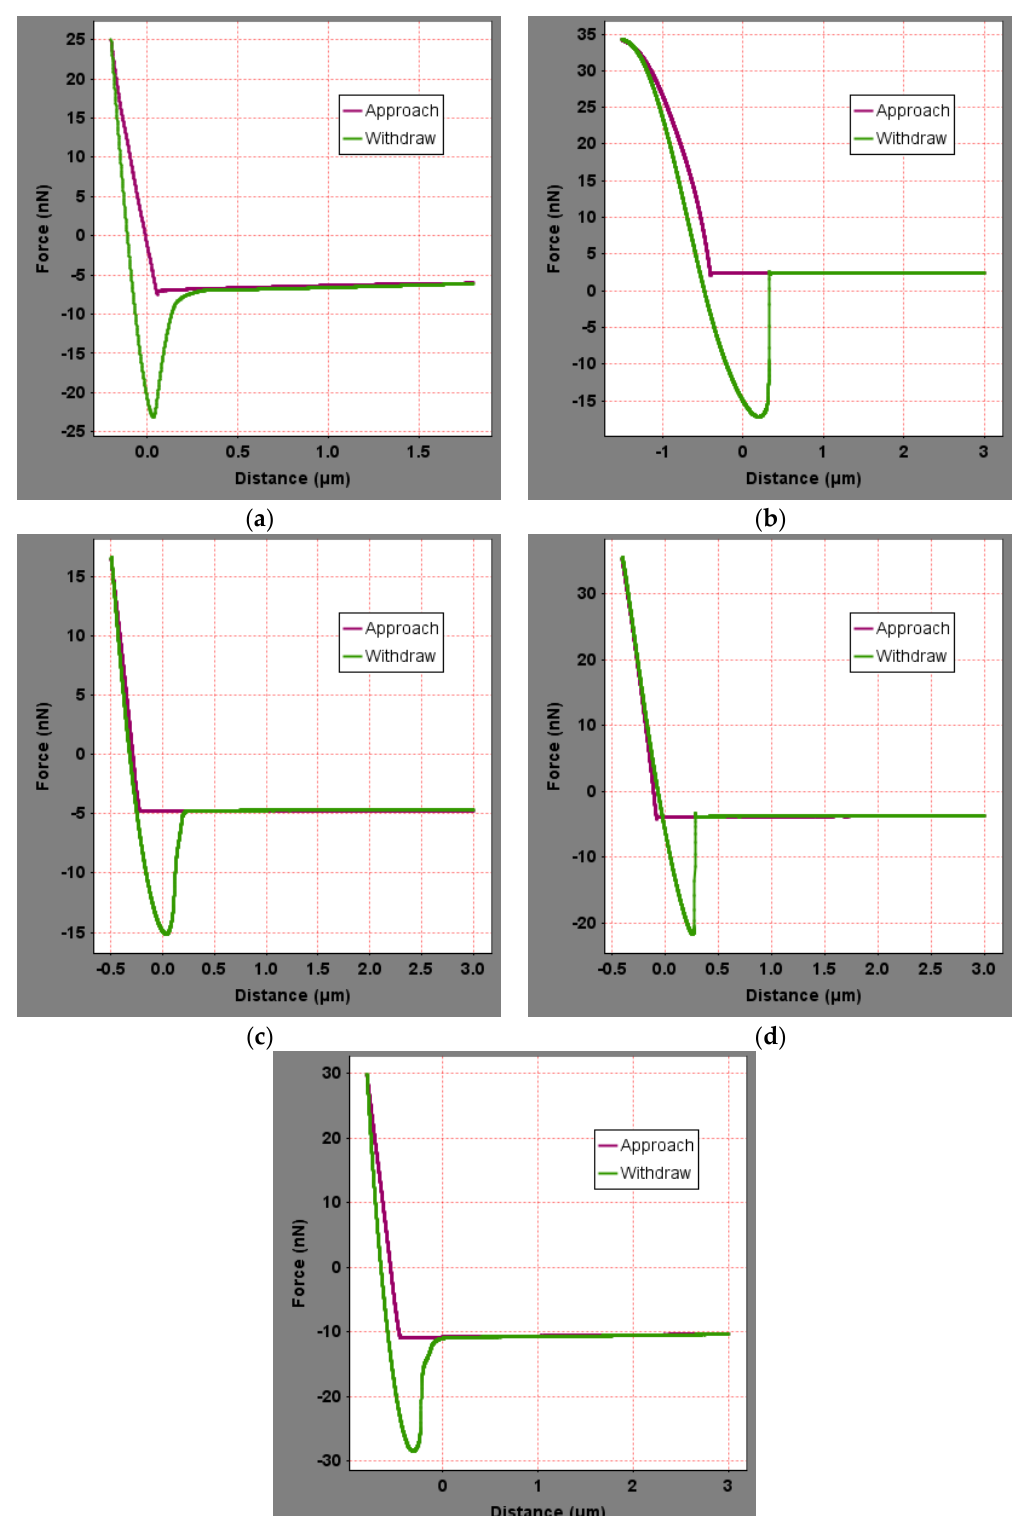
Figure 19. Force curves of the peak region of the bee-like structures in asphalts doped with RAA: ( a ) SK-70; ( b ) SK-90; ( c ) KL-70; ( d ) Shell-70; and ( e ) SBS-modified.